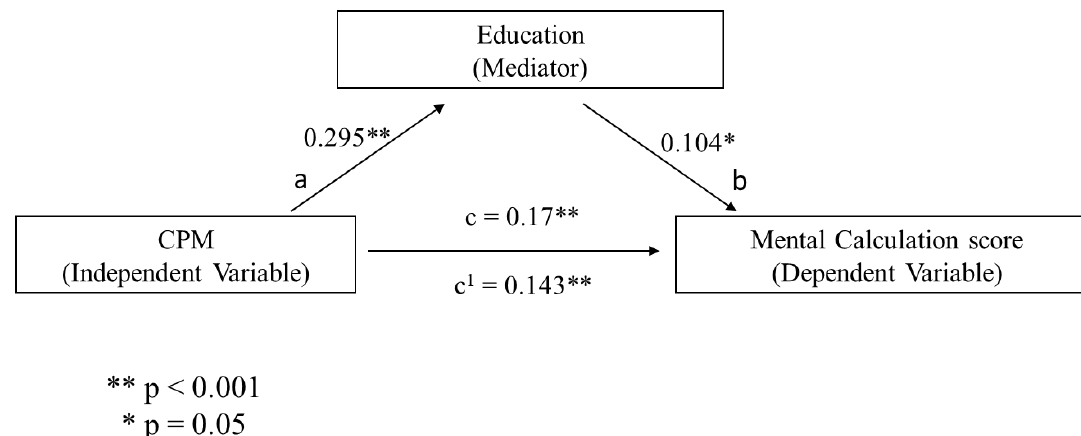
Figure 1. The predicted mediational pattern for Mental Calculation using CPM as the independent variable and educational attainment as mediator.